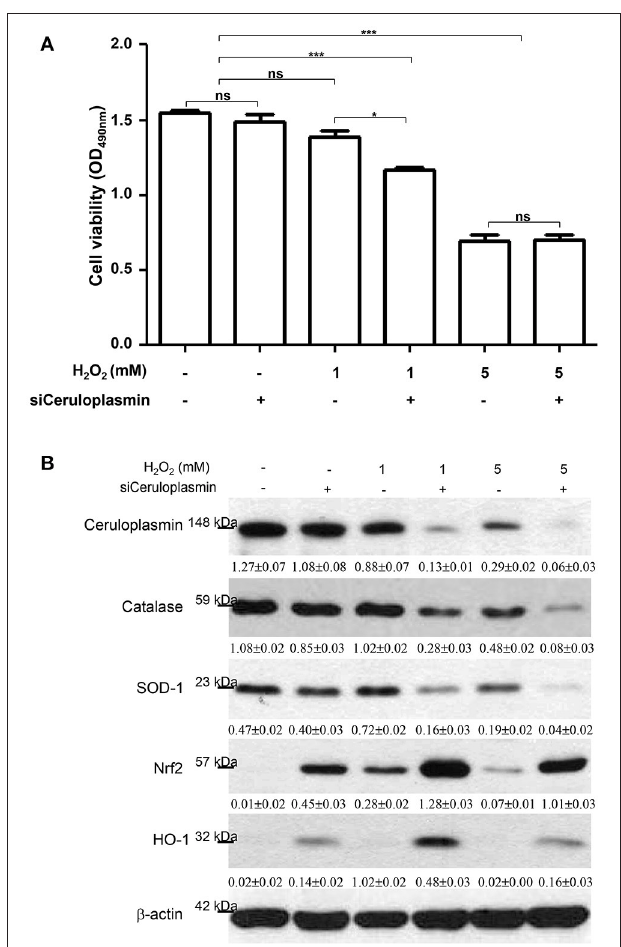
FIGURE 4 | (A) HepG 2 cell viability was determined under the treatments of 0, 1, and 5mM H 2 O 2 with or without ceruloplasmin siRNA (siCeruloplasmin) application. Results represent the mean ± SD of three independent experiments (* p < 0.05, *** p < 0.001). (B) The regulation of antioxidant enzymes and associated molecules under the administration of 0, 1, and 5mM H 2 O 2 with or without ceruloplasmin siRNA. β -actin was applied as the loading control. The relative expression ratio to β -actin is shown at the